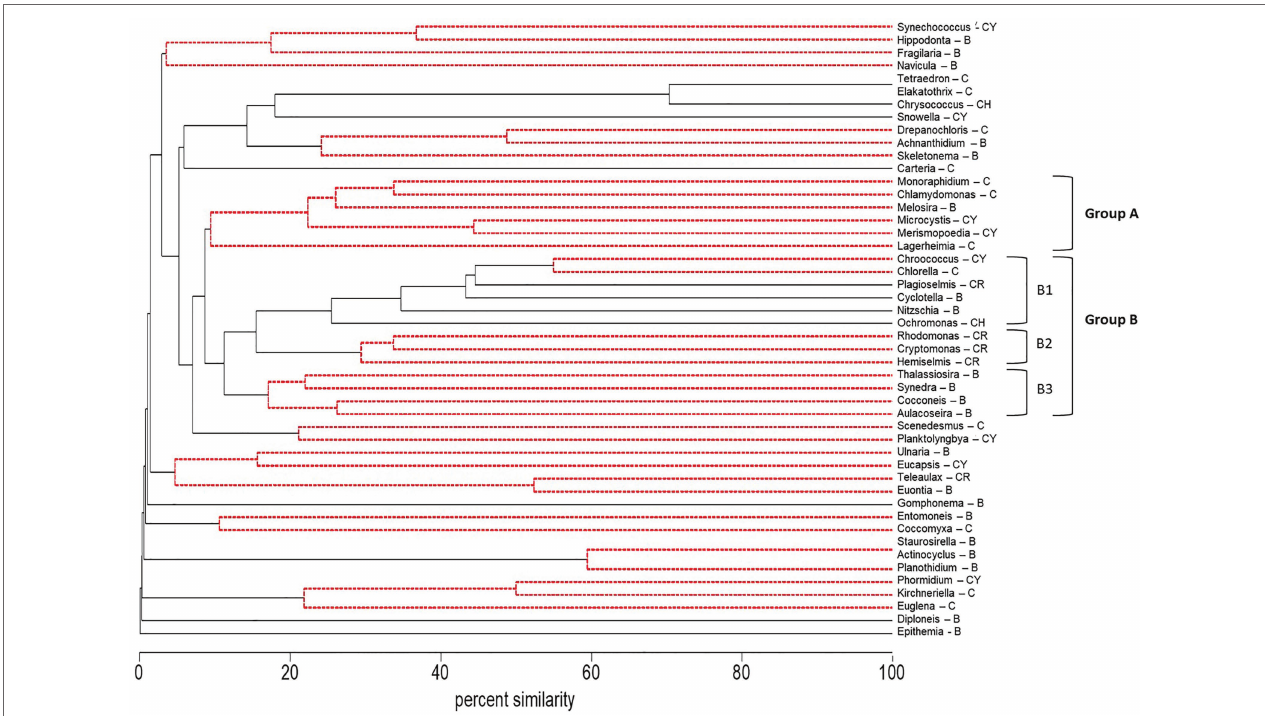
FIGURE 4 | Dendrogram of group average clustering of abundance data for phytoplankton and cyanobacteria genera (microscopy) sampled between 2014 and 2018 at five stations. Differences among genera within clusters were determined by type 3 similarity profile analysis (SIMPROF) as significant (solid black line) or non-significant (dashed red line). Genera which were most coherent with Microcystis are coded as Group A. The next closest cluster of genera coherent with Group A was coded as Group B (with subsets B1, B2, and B3). Phyla associated with each genus are indicated by a letter code after the genus as follows: Bacillariophyta (diatoms, B), Chlorophyta (green algae, C), Chrysophyta (CH), Cryptophyta (CR), and Cyanobacteria